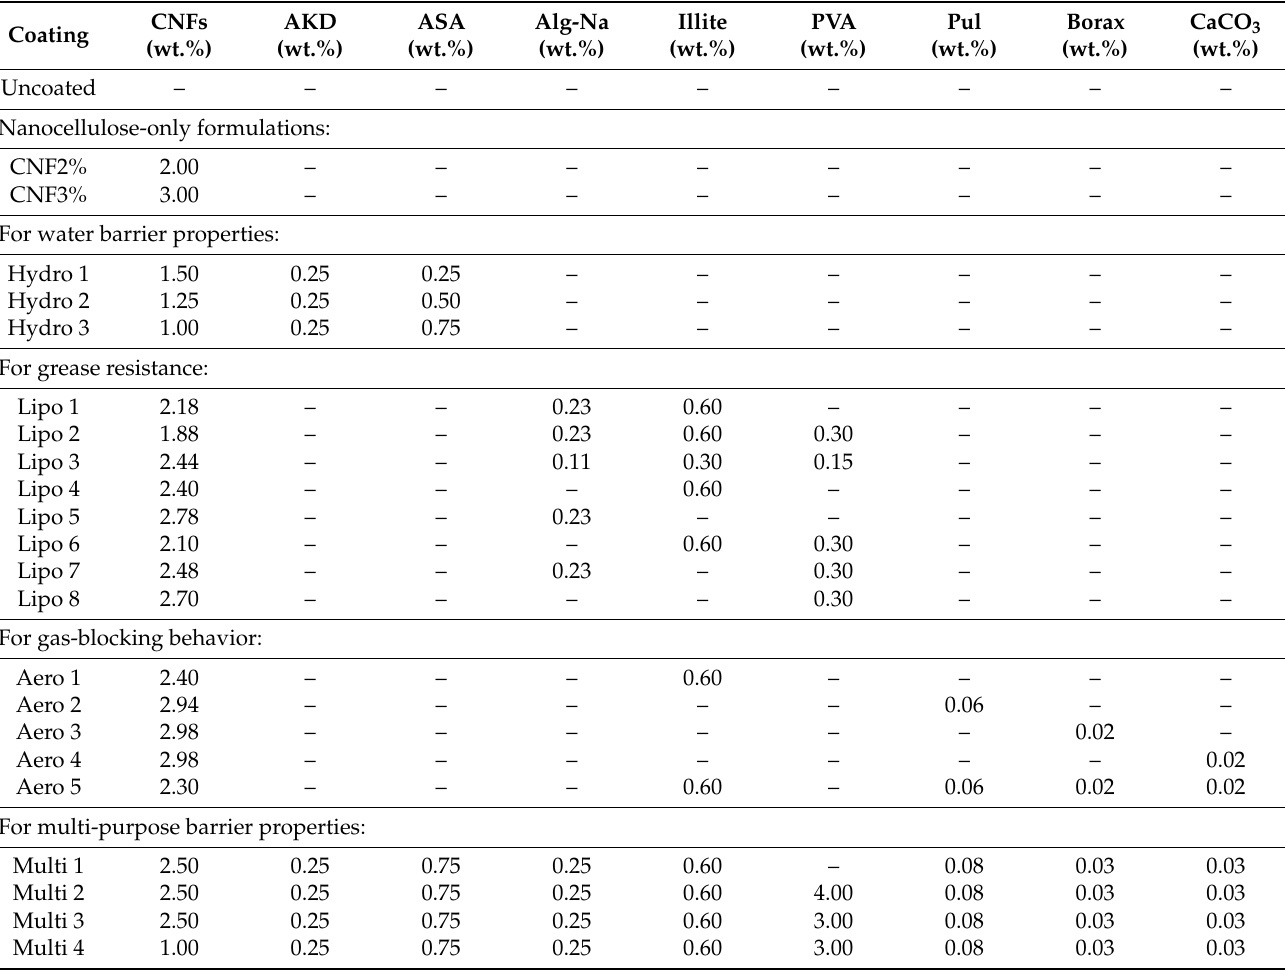
Table 1. Coding and composition of each of the aqueous coating formulations, classified according to their